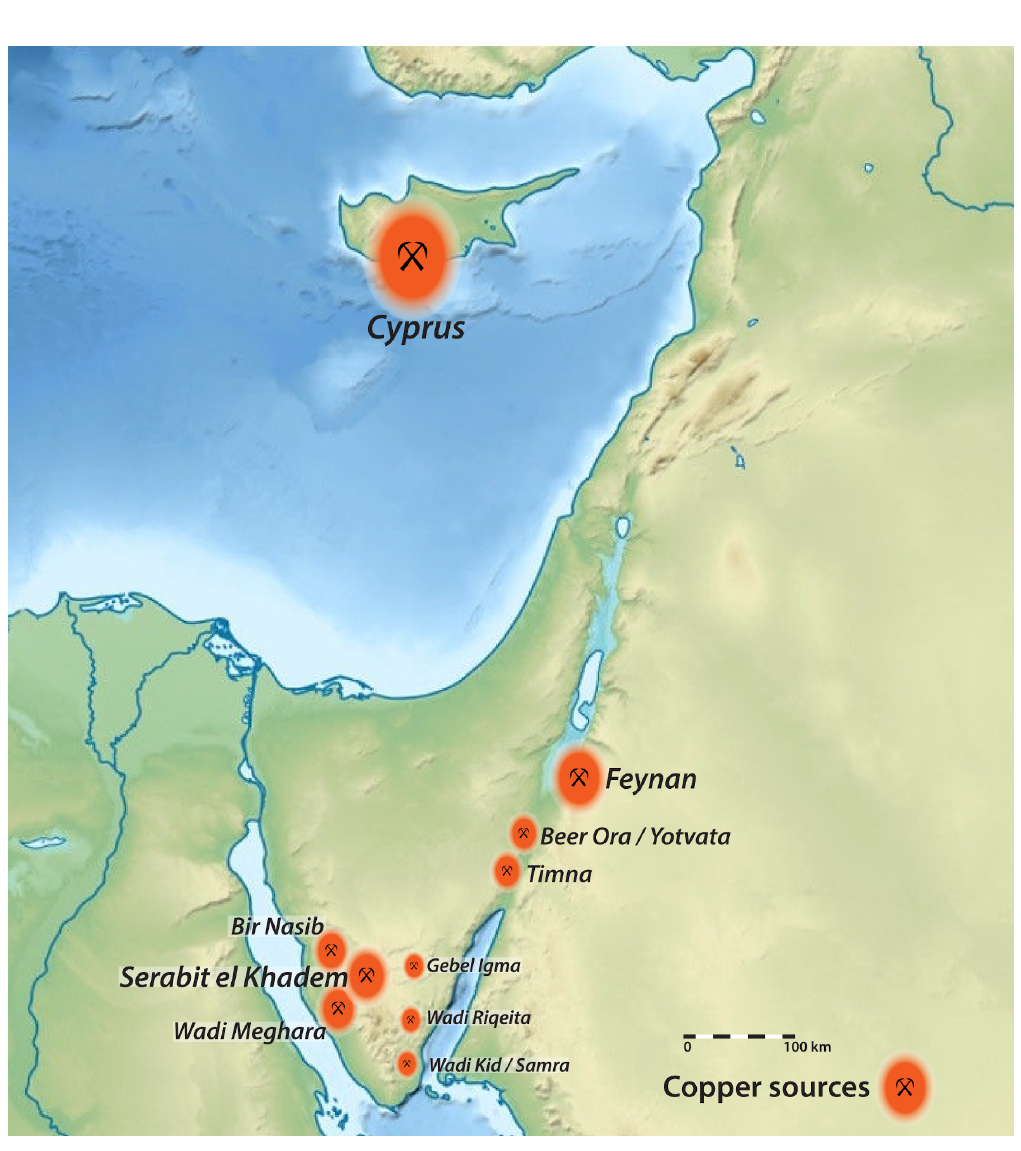
Figure 1 The copper mining areas in activity (Bronze Age and/or Iron Age) in the Southern Levant and its